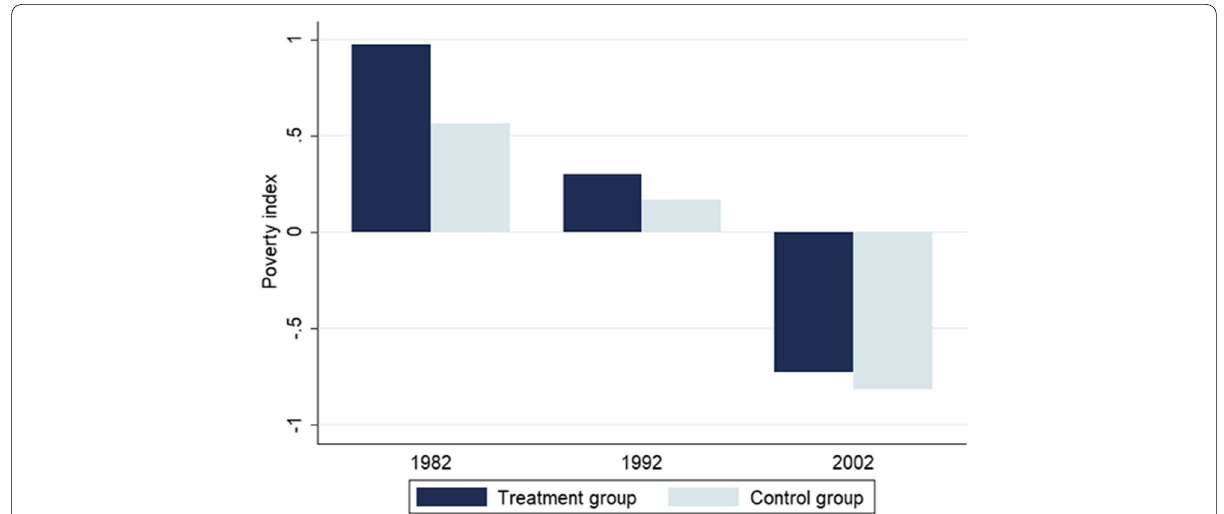
Fig. 2 Average poverty index by year and group. Notes: The treated group consists of units with at least 17% of their terrestrial area protected. The control group consists of units with less than the threshold protected